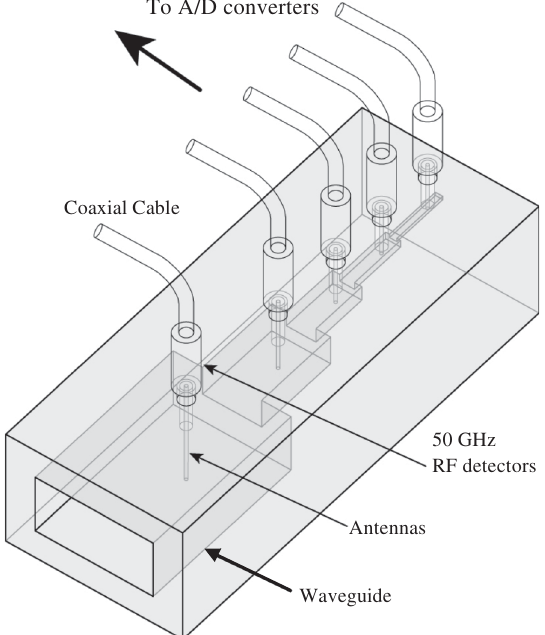
FIG. 18. Structure of the WGSPM comprising the five wave- guides with the different cutoff frequencies. The individual waveguides have 50 GHz rf detectors to observe